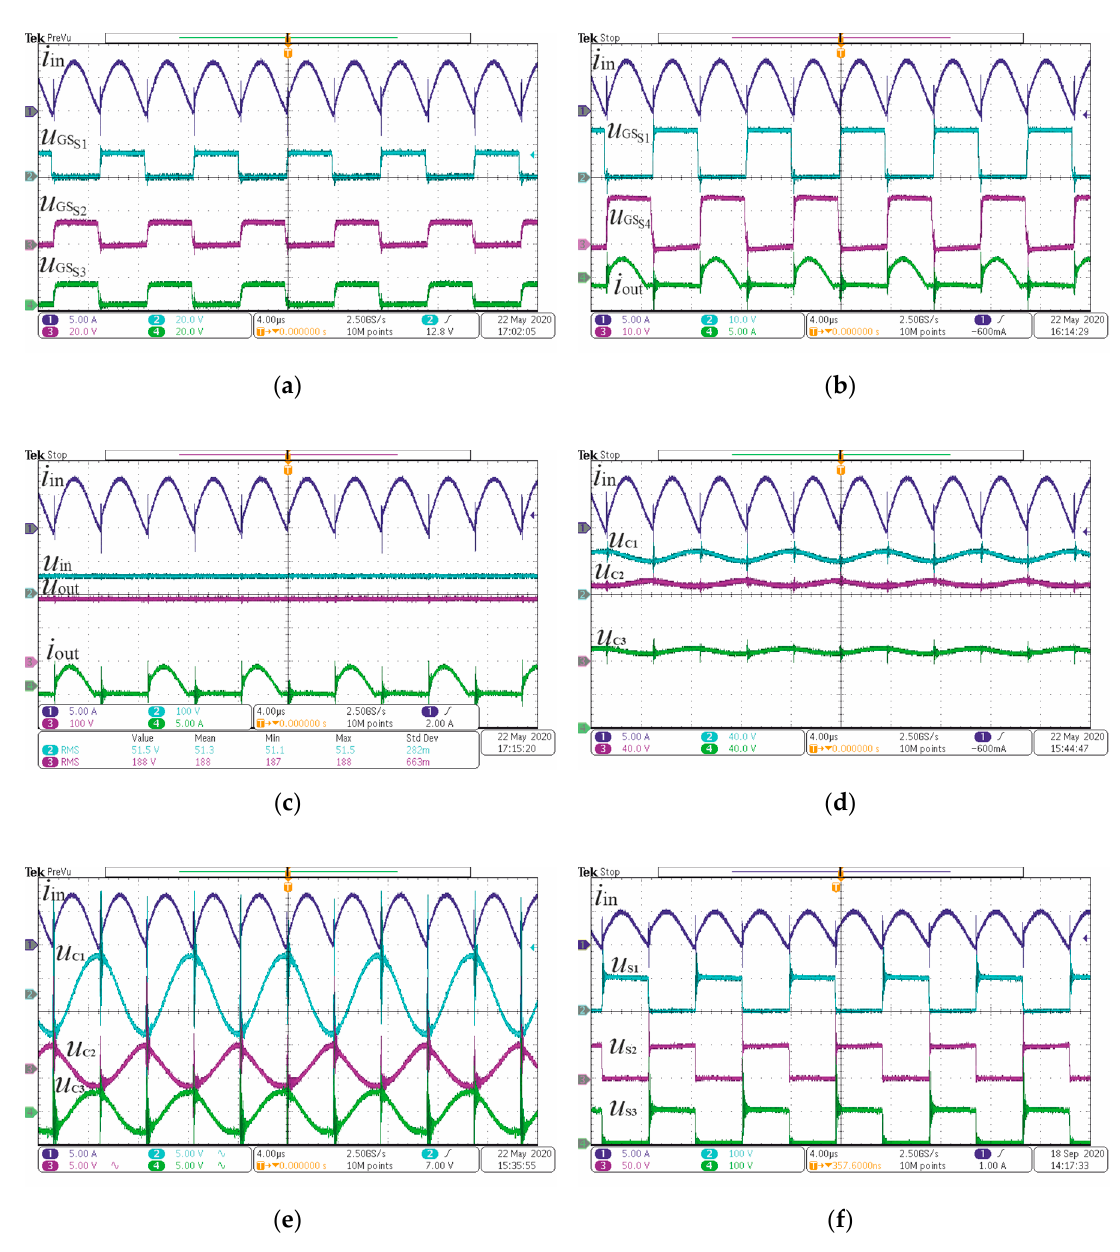
Figure 13. A set of recorded waveforms during experimental tests: ( a ) Switching signals of transistors and the input current, ( b ) input and output current of the converter on the background of switching signals, ( c ) input and output waveforms of the converter (current and voltage traces), ( d ) converter input current and voltages across resonant capacitors recorded in DC coupling mode, ( e ) converter input current and voltages across resonant capacitors recorded in AC coupling mode, and ( f ) voltage stresses across the switches on the background of converter input current. Switching strategy C5.